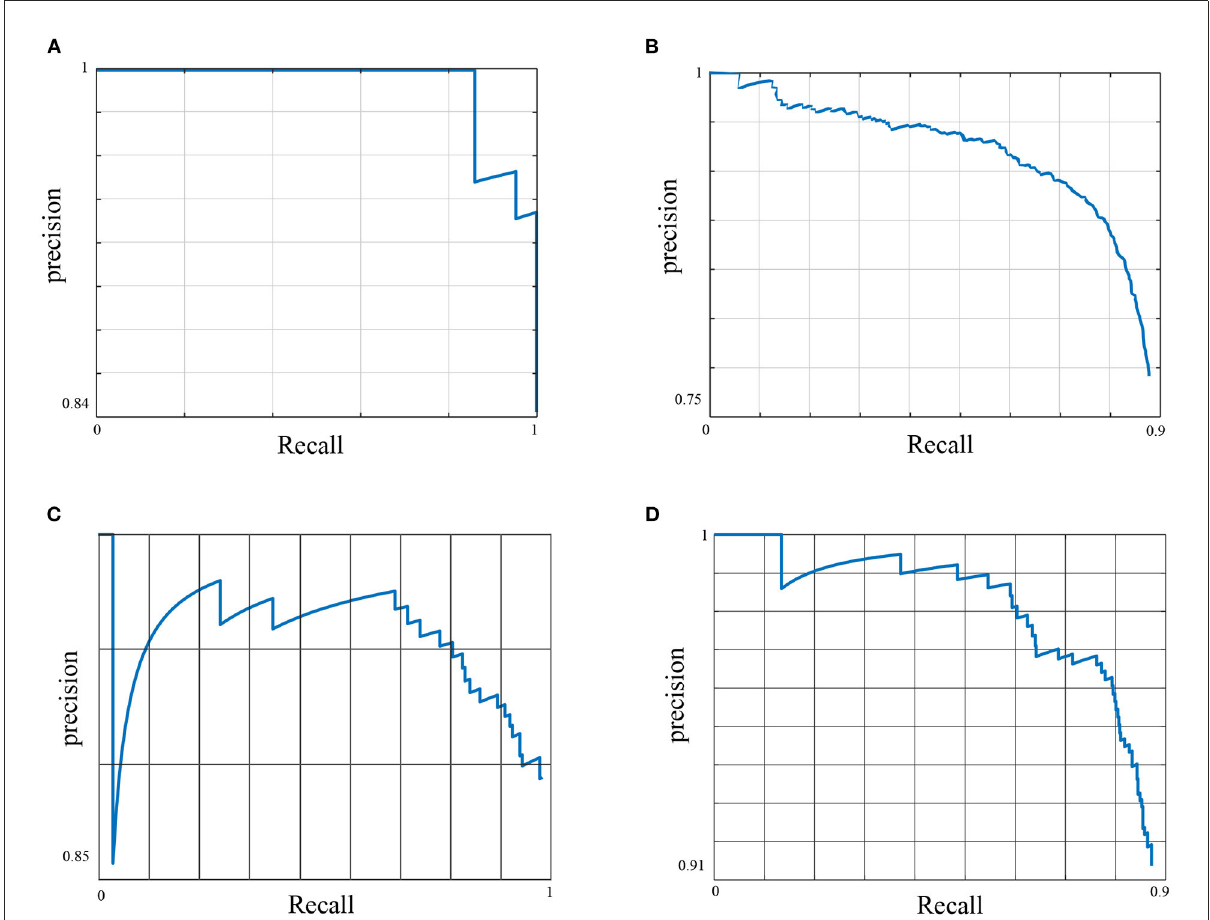
FIGURE1 The Precision Recall (PR) curve of the primary model. The figure shows the trade-off between precision and recall for different thresholds for all data classes. A large area under the curve results from achieving high precision and recall, where high precision relates to a low false positive rate, e.g., detecting an instance of the feeding behavior that has not practically occurred, and high recall relates to a low false negative rate, e.g., the method misses an instance of the feeding behavior that has occurred. (A) Feeding AP 50 = 0.96, (B) Drinking AP 50 = 0.7, (C) Standing AP 50 = 0.85, and (D) Non standing AP 50 =